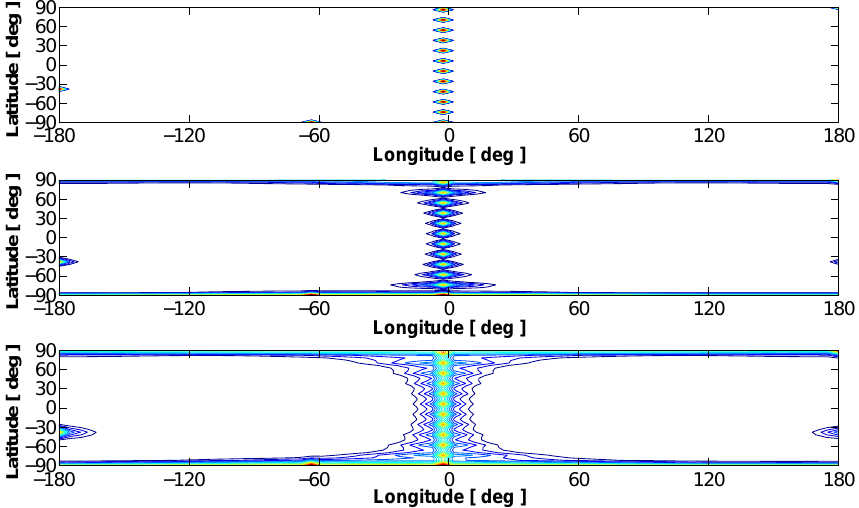
Fig. 2. Contour lines of the longitudinal correlation C x for points at different latitudes. The correlation length ‘ x is short (top panel), medium (middle panel), and large (bottom panel). Note that the same correlation length ‘ x translates into a different number of correlated grid points depending on the